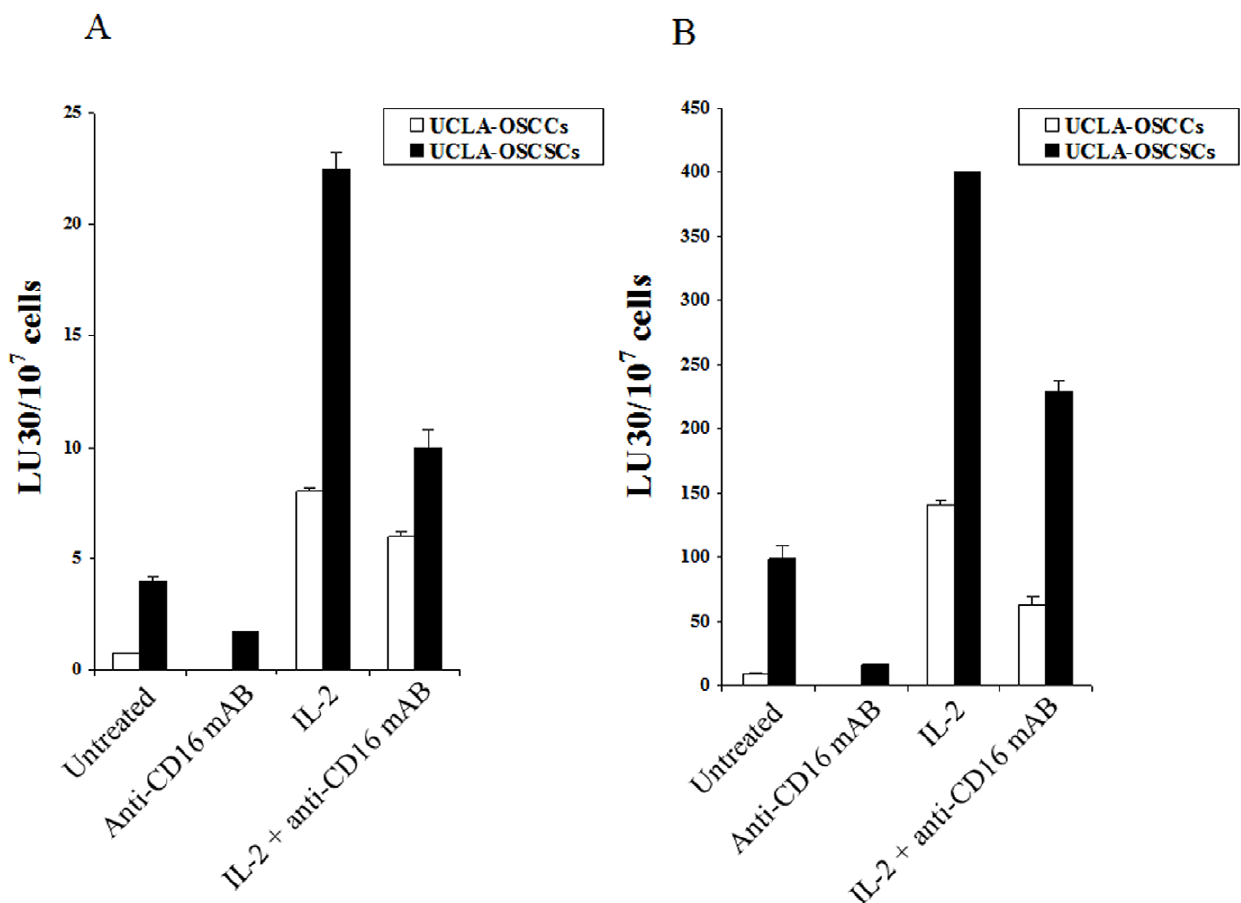
Figure 1. Increased NK cell cytotoxicity against UCLA-OSCSCs. PBMCs and NK cells were left untreated or treated with IL-2 (1000 units/ml) or anti-CD16 mAb (3 m g/ml) or a combination of IL-2 (1000 units/ml) and anti-CD16 mAb (3 m g/ml) for 12–24 hours before they were added to 51 Cr labeled primary oral tumors. PBMC ( A ) and NK cell ( B ) cytotoxicities were determined using a standard 51 Cr release assay and the lytic units 30/10 6 cells were calculated using inverse number of effectors required to lyse 30% of the tumor cells 6 100. Differences between untreated, anti-CD16 mAb treated or IL-2 and/or anti-CD16 mAb treated NK cell cytotoxicity between UCLA-OSCCs and UCLA-OSCSCs were significant at a p value of , 0.05. One of four representative experiments is shown in this figure.